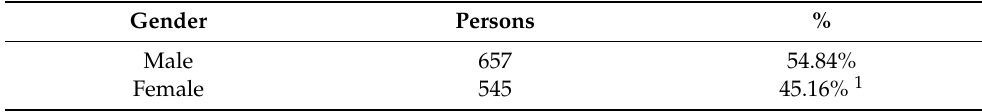
Table 1. Demography data of population in Guilin